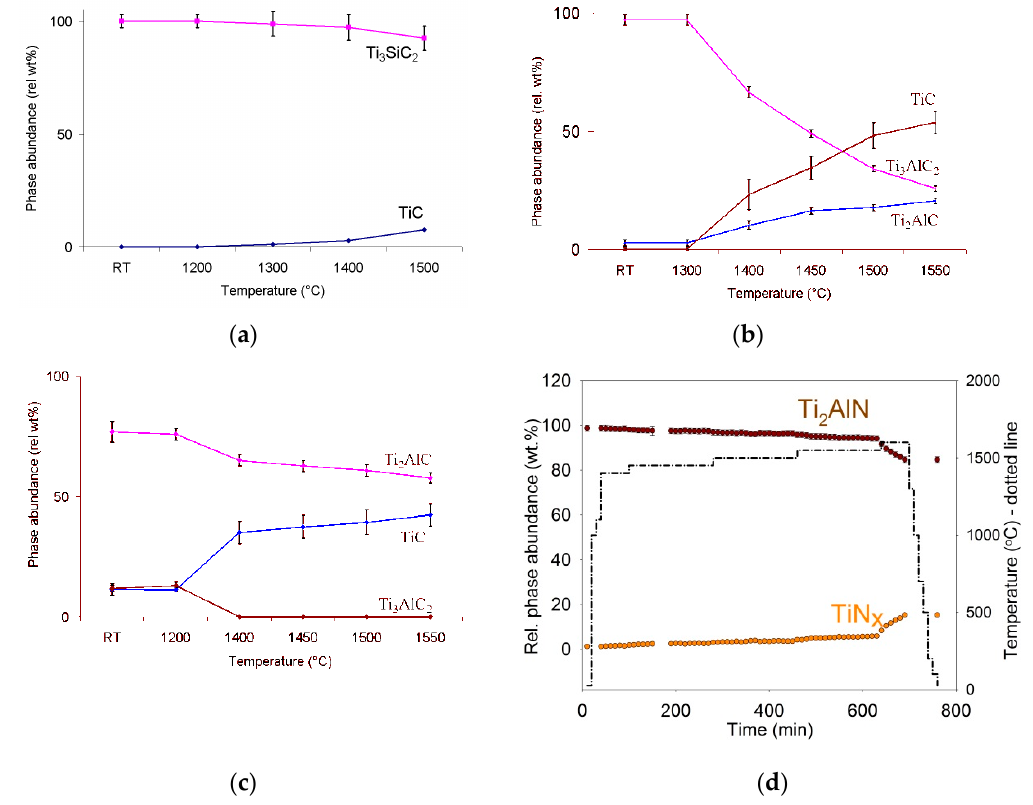
Figure 2. Phase abundance as a function of temperature for the decomposition of ( a ) Ti 3 SiC 2 , ( b ) Ti 3 AlC 2 , ( c ) Ti 2 AlC, and ( d ) Ti 2 AlN in vacuum. Courtesy of AZom.com [10].